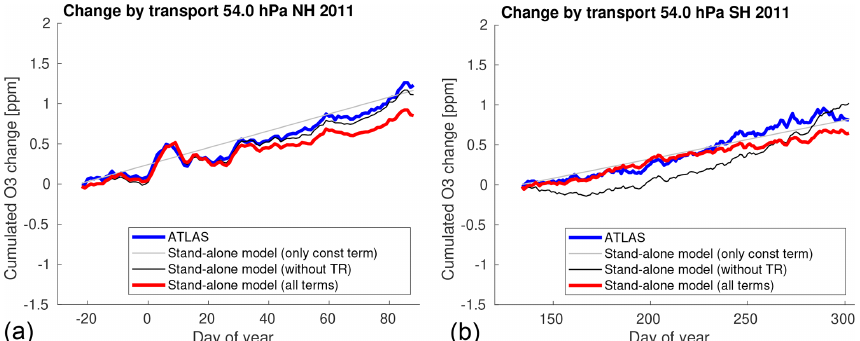
Figure 5. Cumulated vortex-averaged ozone change by transport at 54hPa for the Northern Hemisphere winter 2010/2011 (a) and the Southern Hemisphere winter 2011 (b) as in Fig. 1e and f (blue) and a simulation of the cumulated change by transport by a stand-alone version of the transport parameterization (red). The thin gray line shows a simulation with only the constant-change term, and the thin black line shows a simulation with the constant-change and temperature-dependent term, but without subtracting the change of the radiative equilibrium temperature from the vortex-averaged temperature